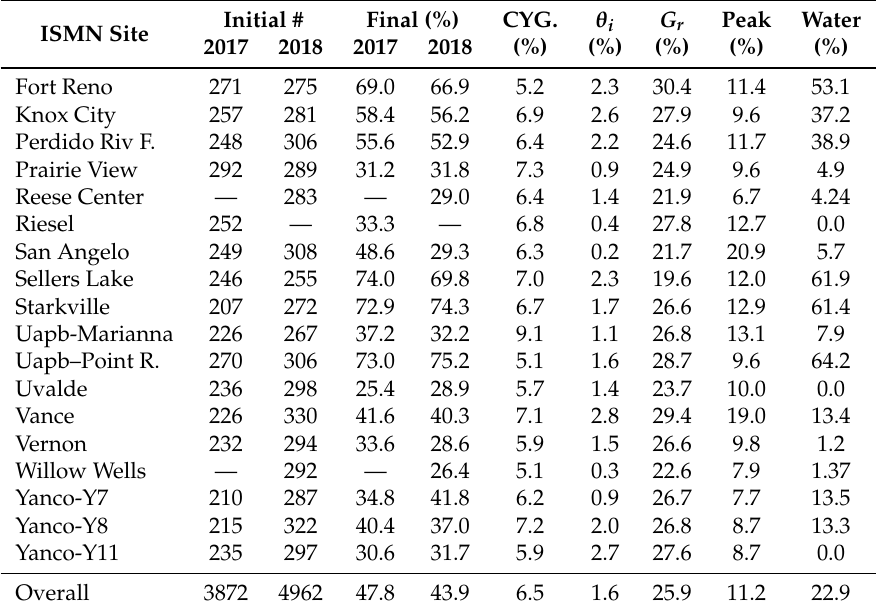
Table 3. The separate, ideal impact of each quality control is shown as percent changes to the original data set: If each quality flag was applied alone to the original data set, the percent changes to the original data set would be as given from the sixth to tenth columns (CYG.: CYGNSS quality flags, θ i : θ i < 65 ◦ , G r : Positive receiver gain, Peak: DDM peak delay bin rows in [7, 10], Water: Removal of inland water bodies). For reference, the initial numbers of data samples before the application of the quality controls are given annually in the second and third columns. Percent losses in the data set due to the actual application of the entire quality controls are also given in the fourth and fifth columns. Overall data set sizes and percent changes are given in the bottom-most row. Year 2017 data for the ISMN sites, Reese Center and Willow Wells, have not been analyzed because these stations are located over 1000 meters, and CYGNSS has an elevation upper limit of 600 m for the SP calculation algorithm until December 2017 [22]. Year 2018 data for the Riesel station have not been analyzed as well due to large blocks of invalid SM